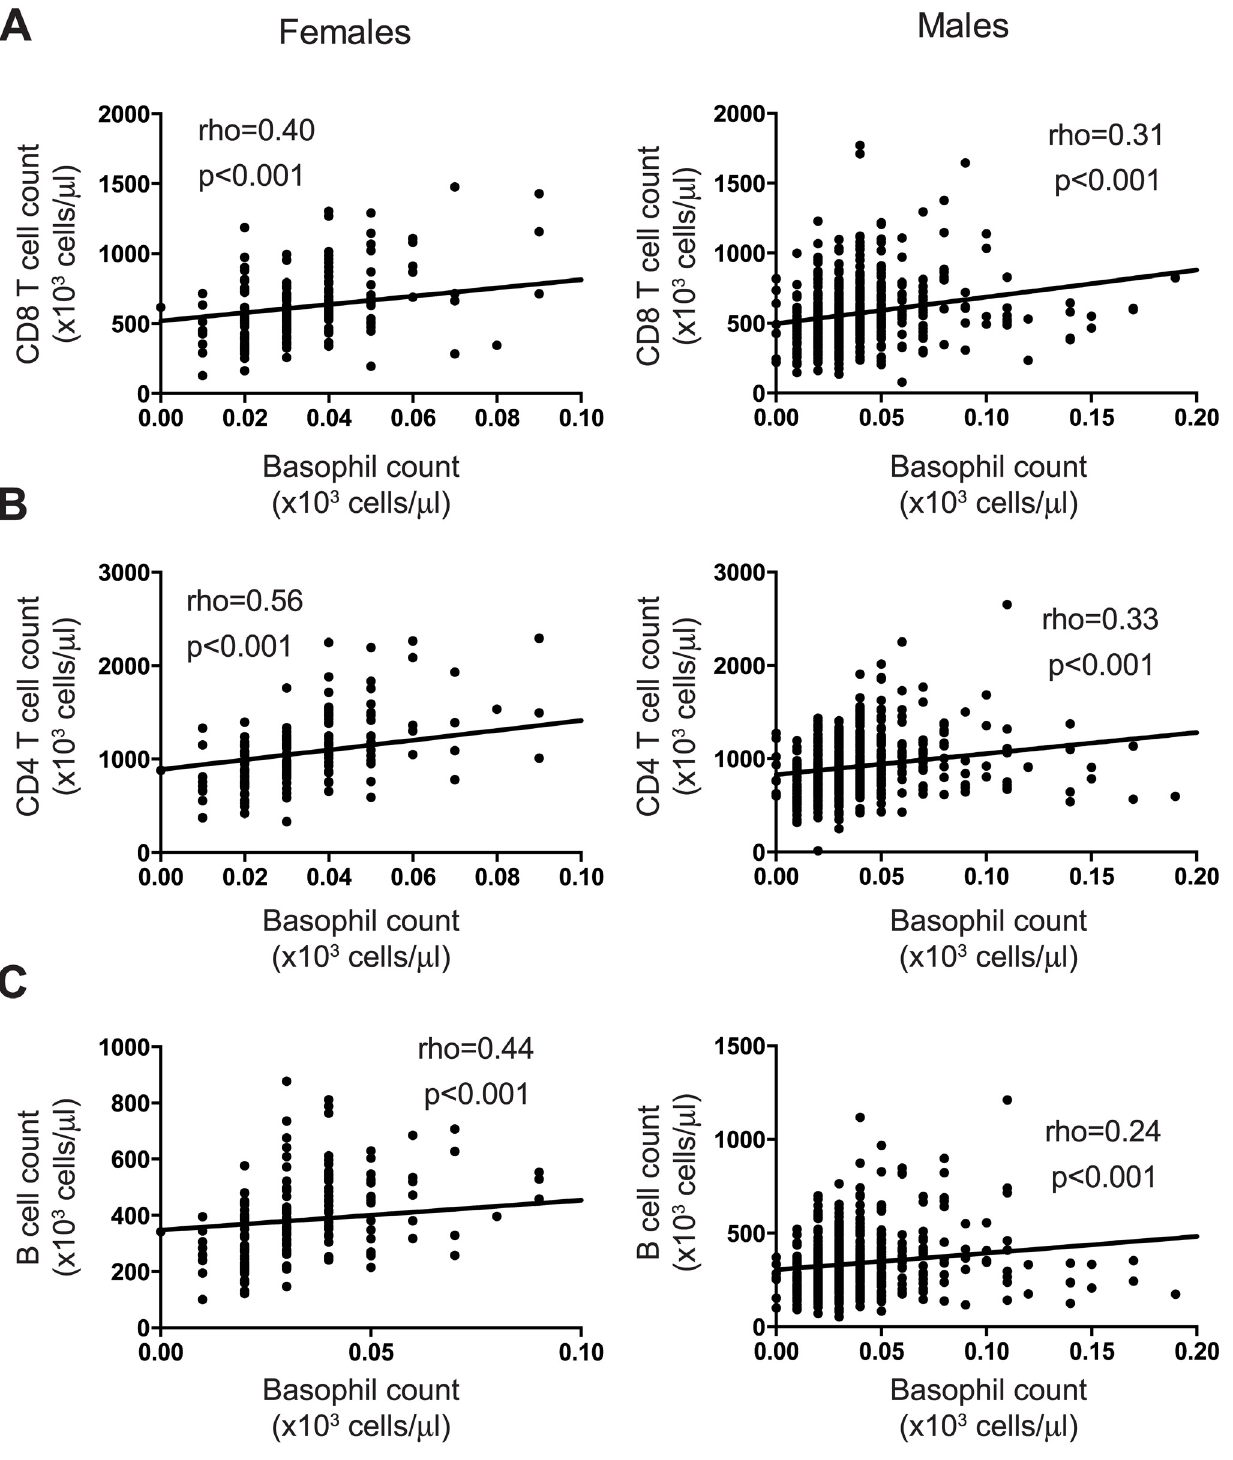
Fig 4. Associations between lymphocyte and basophil counts. Correlation graphs of (A) basophil and CD8 T cell counts; (B) basophil and CD4 T cell counts; and (C) basophil and B cell counts. The Spearman ’ s rank correlation was used to assess associations between parameters, with rho (cid:1) 0.25 and p values < 0.05 considered statistically